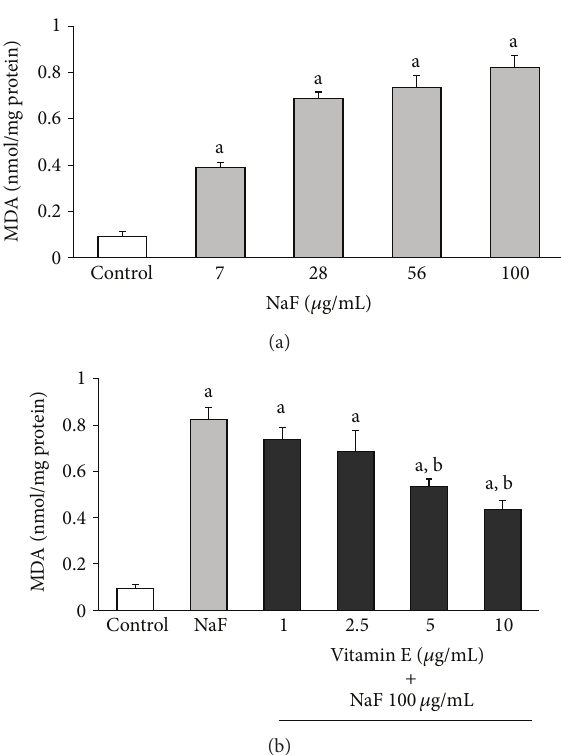
Figure 1: MDA concentration in the membrane of erythrocytes incubated3hourswithincreasingconcentrationsofsodiumfluoride (NaF) (a) or incubated with 100 𝜇 g/mL NaF or 100 𝜇 g/mL NaF with Vit-E in increasing concentrations (b). The results are expressed as themean ± standarddeviationoffiveindependentexperiments,tak- ing two samples per experiment and performing the determinations in triplicate. a 𝑃 < 0.05 compared with the control group; b 𝑃 < 0.05 compared with the group incubated with only 100 𝜇 g/mL